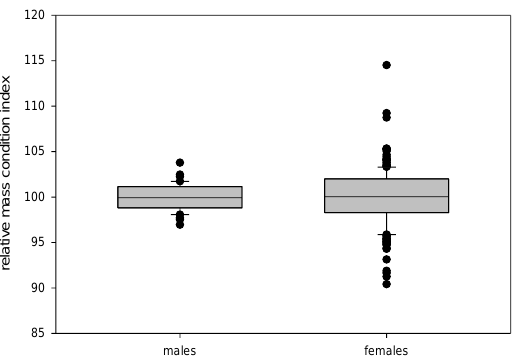
Figure 6. Strong linear correlation between log 10 transformed data on cranial width ( x -axis) and caudal with ( y -axis) of Xenopus laevis frogs of both sexes ( n = 238; y = 1.08x + 0.03; R 2 = 0.91). The relative mass condition index W R was calculated separately for each sex because of the differences in body weight and morphology observed in the morphometric param- eters described above. The females showed a considerably higher variation of this index (Figure 7). The triangle surface and W R did not correlate well in females (y = 0.23x + 93.00; R 2 = 0.17) and males (y = 0.05x + 99.46; R 2 = 0.001).